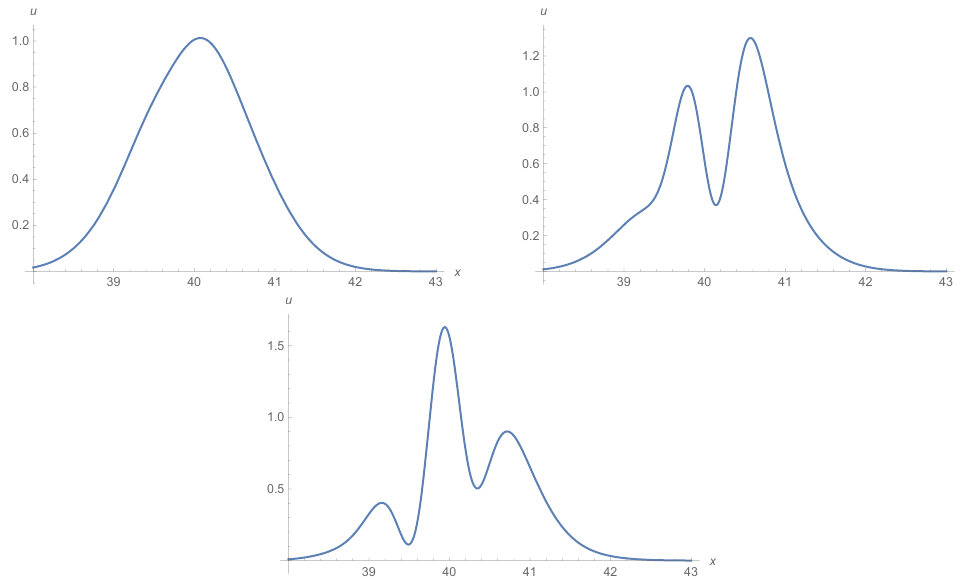
Figure 5. The solution of Equation (1) using ADM when p = 2, (cid:101) = 6 when t = 2 and µ = 0.5 (Single soliton), µ = 0.05 (two solitons), µ = 0.005 (three